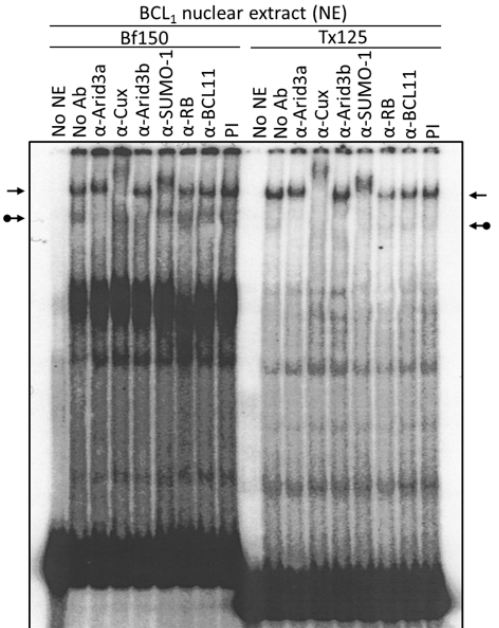
Figure 3. Arid3a and NF- µ NR complexes with promoter-associated MARs are composed of heterogeneous proteins. BCL 1 nuclear extract was prepared and subjected to EMSA using 32 P-labeled Bf150 or Tx125 fragments as probes. Super-shift assays were performed with antisera or mAb ( α ) listed above the corresponding lanes. Plane arrows indicate the mobility of the NF- µ NR complex; arrows with balls, the Arid3a complex. No NE: free probe, PI: pre-immune serum.